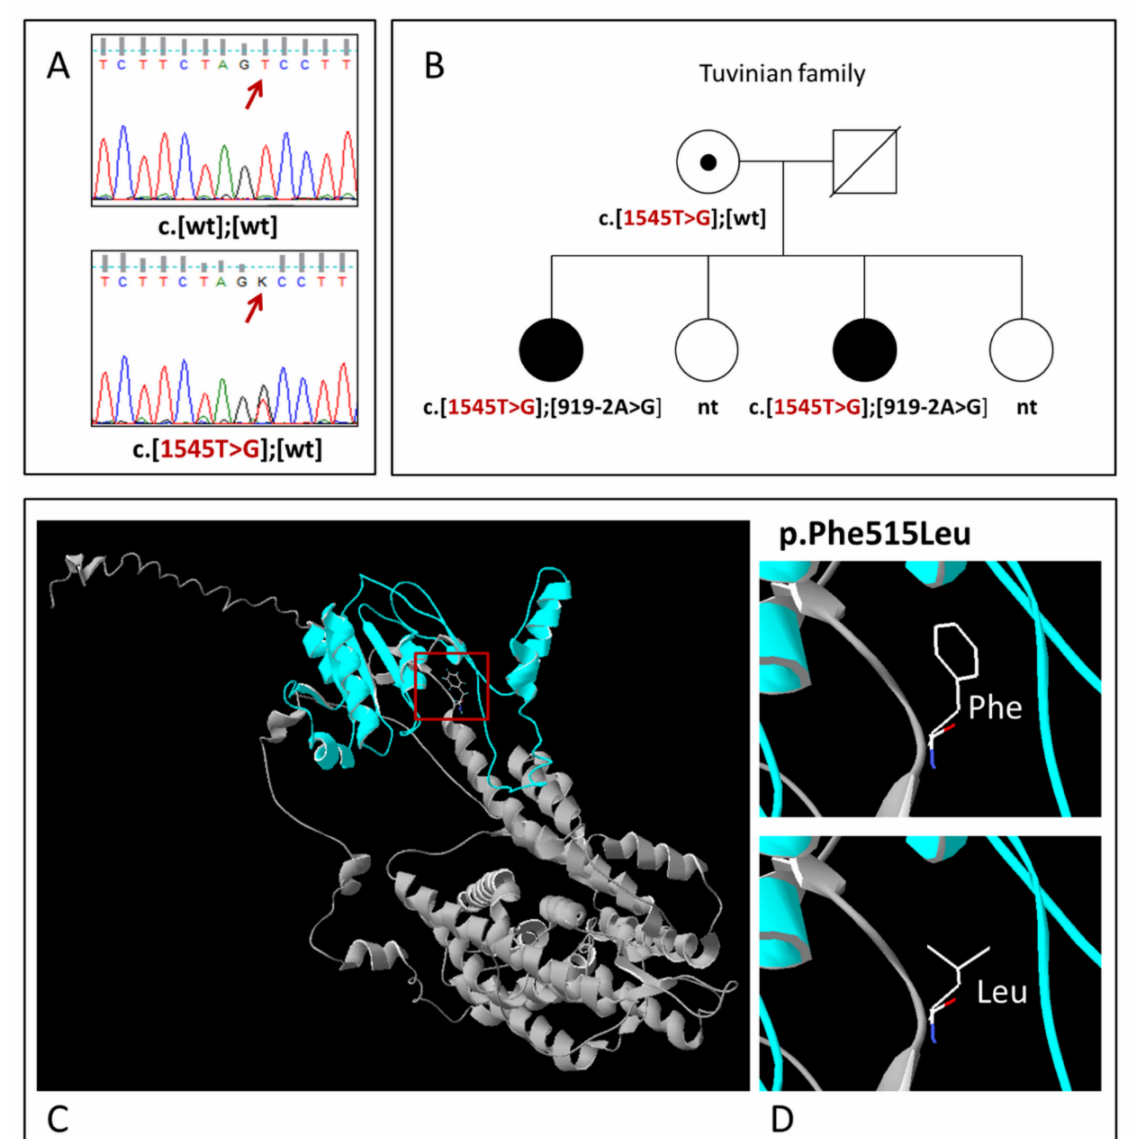
Figure 2. ( A ) Identification of variant c.1545T>G (p.Phe515Leu) by Sanger sequencing; ( B ) The pedigree of the Tuvinian family demonstrating the segregation of variant c.1545T>G (p.Phe515Leu) in compound with recessive mutation c.919-2A>G with HL. Deaf individuals are shown by black symbols; the variant c.1545T>G (p.Phe515Leu) is shown by red; nt—not tested; wt—wild-type; ( C ) The 3D structure of the pendrin protein with localization of variant p.Phe515Leu; ( D ) Close-up views of wild (Phe515) and mutant (Leu515) types of